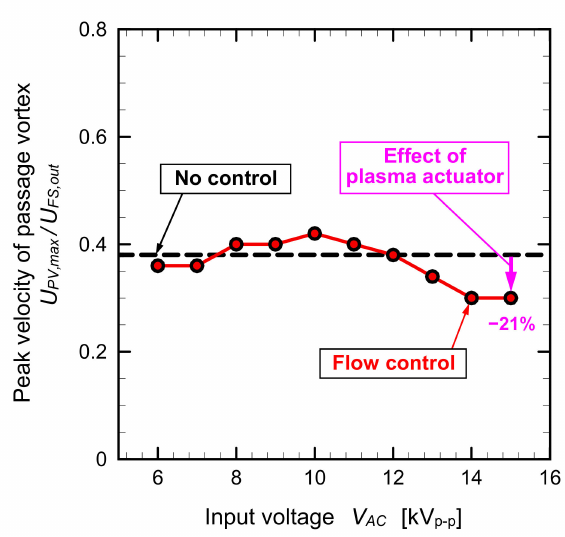
Figure 17. Peak velocity of passage vortex in center passage ( U FS , out = 4.7 m / s).